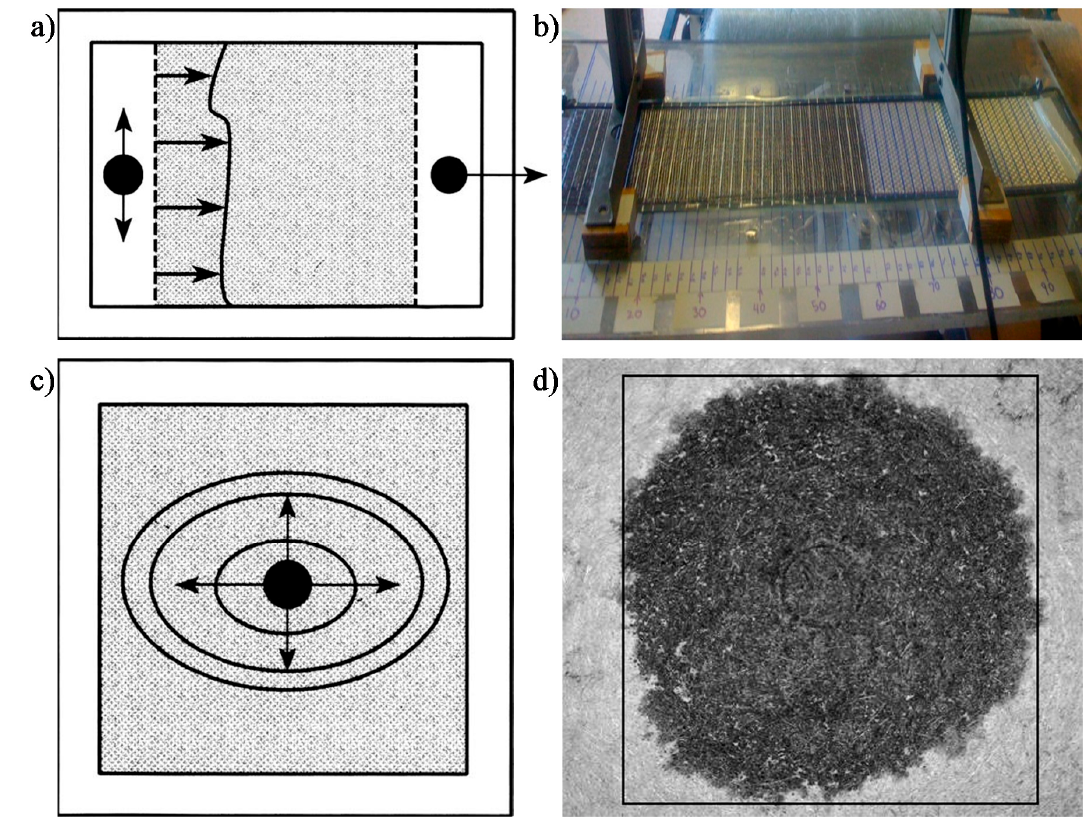
Figure 5. Permeability measurement and flow visualisation setups: ( a , b ) 1D linear flow through line gate injection [57]; ( c , d ) 2D radial flow through central injection [19,57]; ( a , c ) reproduced from [57], with permission from © 1995 Wiley; ( d ) reproduced from [19], with permission from © 2011 Taylor and Francis.